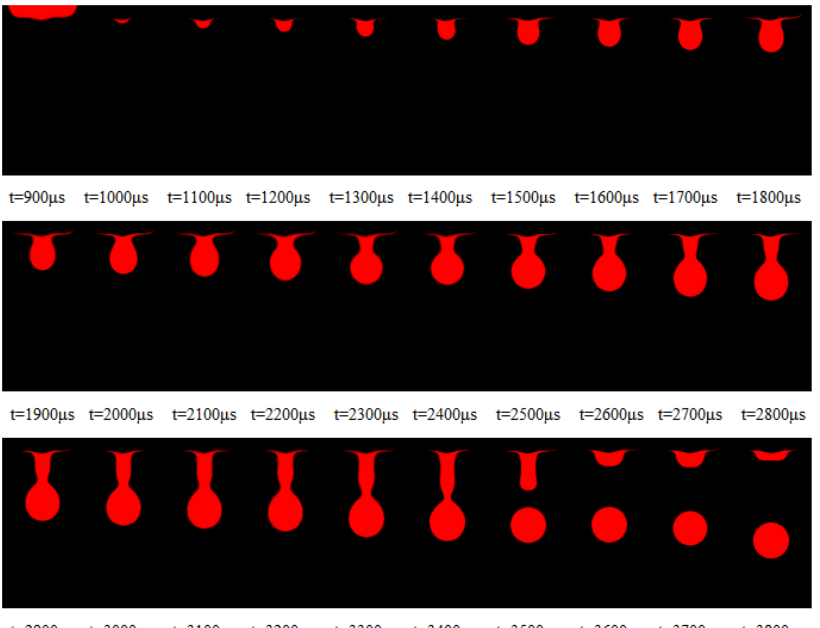
Table 3. Average abscissa, ordinate, and velocity of droplets at different times and their corresponding standard deviations.